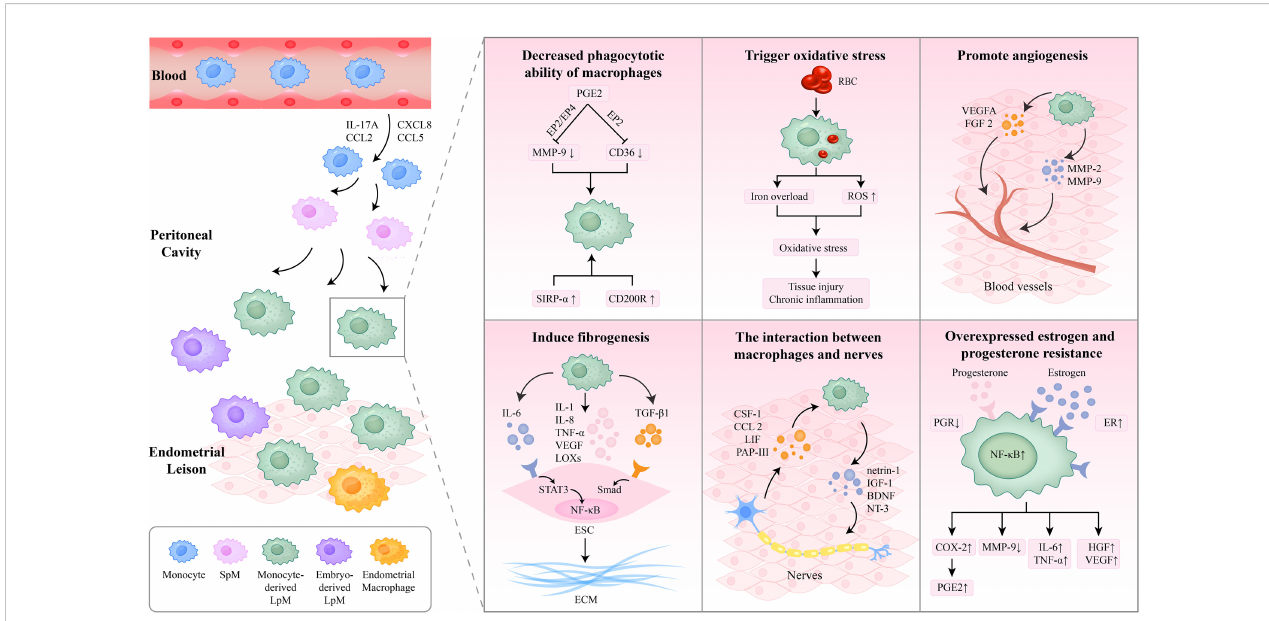
FIGURE 2 The role macrophages play in the pathogenesis of endometriosis. The macrophages in the endometriotic lesions are composed of embryo-derived LpM and SpM, eutopic endometrial macrophages, and monocyte-derived LpM. Monocyte-derived macrophages were recruited into the peritoneal cavity and replenished the LpM pool. The decreased phagocytotic capacity of macrophages contributes to ESC survival and endometriotic tissue growth. Oxidative stress in macrophages triggers oxidative damage, tissue injury, and chronic in fl ammation. Macrophages promote angiogenesis and fi brosis through a variety of cytokines. Furthermore, the interaction between macrophages and nerves promotes the development of endometriosis. Additionally, overexpressed estrogen and progesterone resistance in fl uence the function of macrophages. IL, interleukin; SpM, small peritoneal macrophages; LpM, large peritoneal macrophages; PGE2, prostaglandin E2; MMP, matrix metalloproteinase; SIRP- a , signal regulatory protein- a ; RBC, red blood cell; ROS, reactive oxygen species; VEGF, vascular endothelial growth factor; FGF, fi broblast growth factor; TNF- a , tumor necrosis factor- a ; LOXs, lysyl oxidases; TGF, transforming growth factor; NF- k B, nuclear factor kappa B; ESC, endometrial stromal cell; ECM, extracellular matrix; CSF, colony-stimulating factor; LIF, leukemia inhibitory factor; PAP-III, pancreatitis- associated protein III; IGF-1, insulin-like growth factor-1; BDNF, brain-derived neurotrophic factor; NT-3, neurotrophin-3; PGR, progesterone receptor; ER, estrogen receptor; COX-2, cyclo-oxygenase 2; HGF, hepatocyte growth